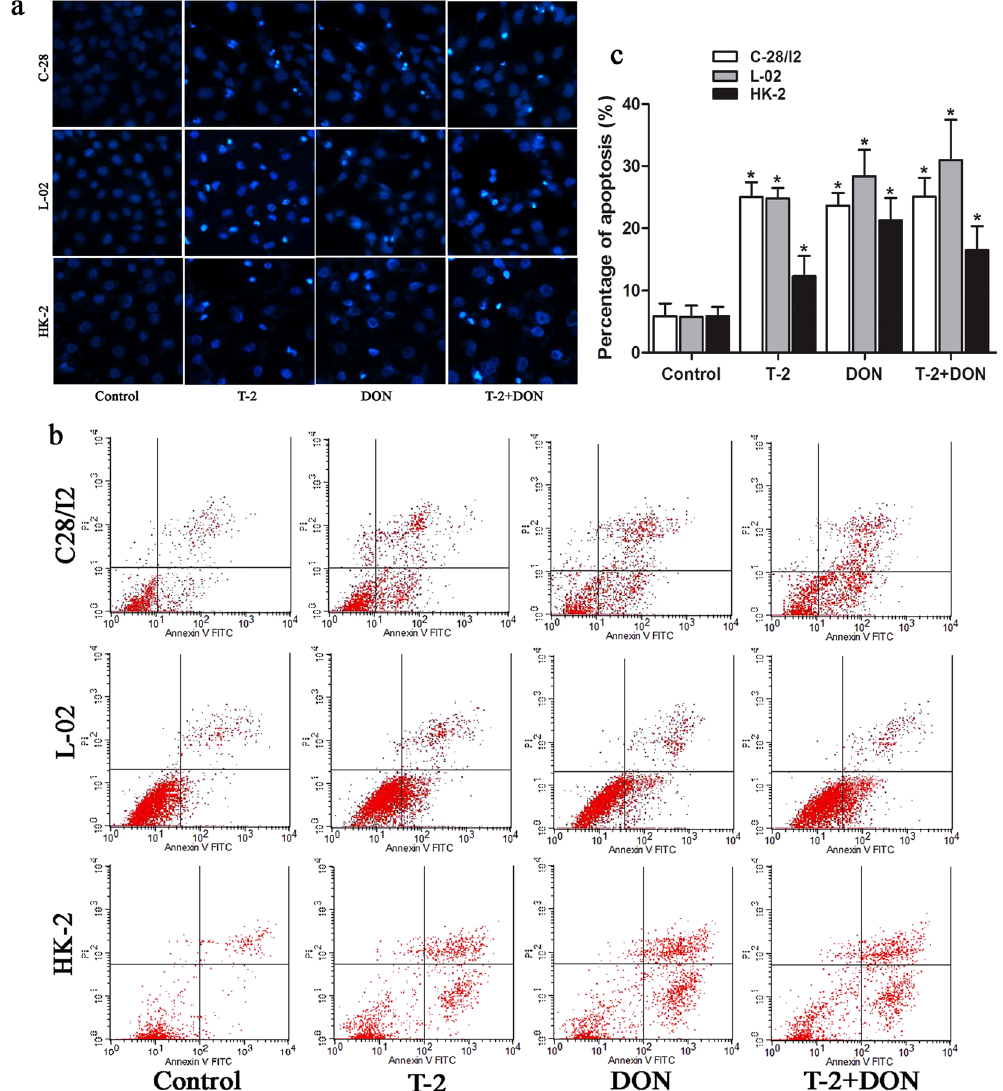
Figure 6. Apoptosis induced by T-2 toxin and/or DON. C28/I2, L-02, or HK-2 cells were exposed to T-2 toxin (10 ng/ml) or DON (800 ng/ml), alone or in combination for 24 h and analyzed for ( a ) morphologic changes of apoptotic cells by staining with Hoechst 33342, visualized by a fluorescence microscopy (Magnification: 200 × ) and ( b ) apoptotic rate by flow cytometry; ( c ) apoptotic rate was quantified as the percentage of apoptotic cells. Data are represented as the mean ± SD from three independent experiments; * P < 0.05 indicated significant differences versus untreated control